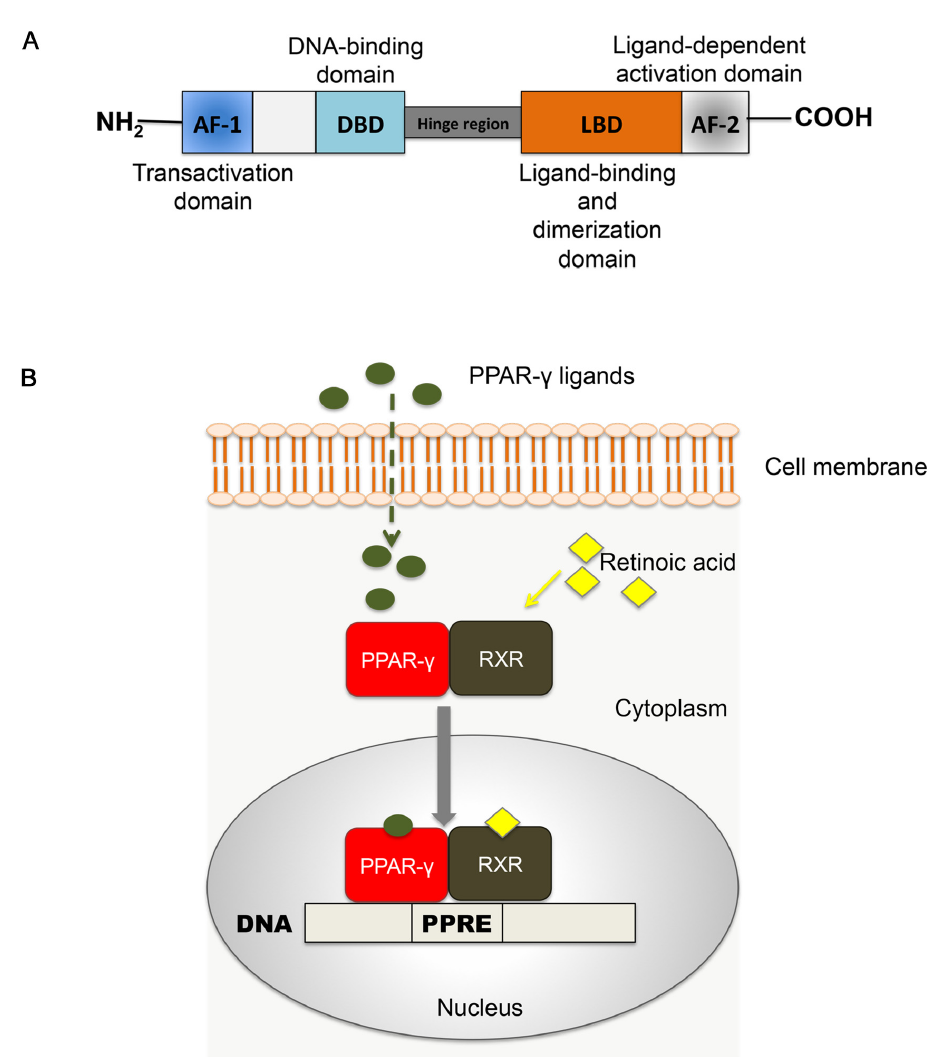
Figure 1. Peroxisome proliferator-activated receptors (PPARs). ( A ) Schematic representation of functional domains in PPAR. AF-1: domain of activation function 1; DBD: DNA-binding domain; LBD: ligand binding domain; AF-2: domain of activation function 2. ( B ) Mechanism of PPAR-RXR